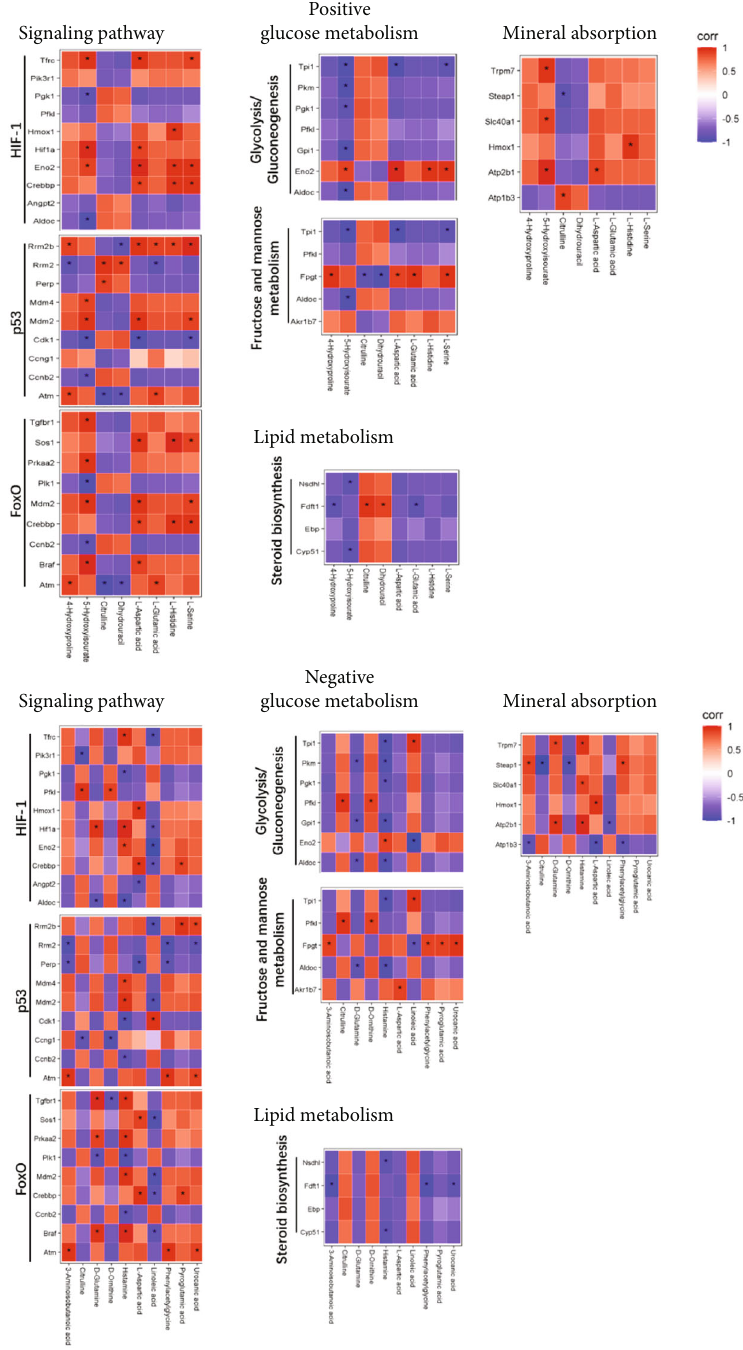
Figure 4: Heatmap indicating the correlation between the di ff erential transcripts and metabolites. Red ( corr = 1 ), blue ( corr = − 1 ), and white ( corr = 0 ); ∗ P < 0 : 05 for Spearman